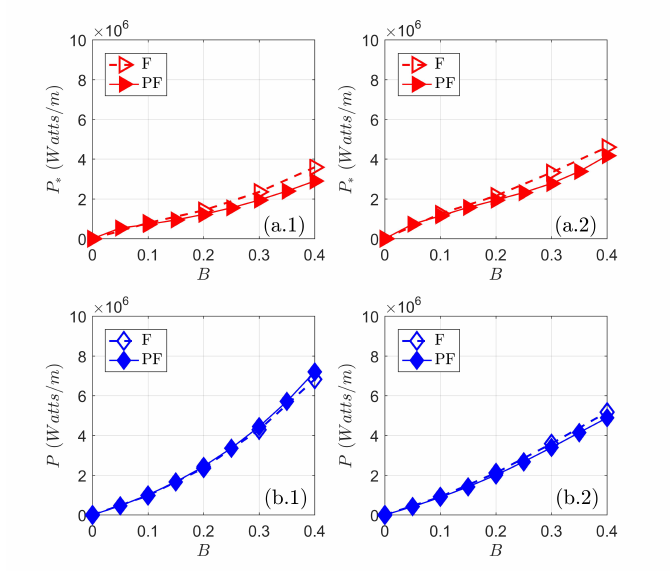
Figure 8. Effect of blockage ratio on P ∗ ( a ) and P ( b ) for a fence (dash-line) and partial-fence (continuous-line) configuration. Solutions obtained from ADI (*.1) and TVD